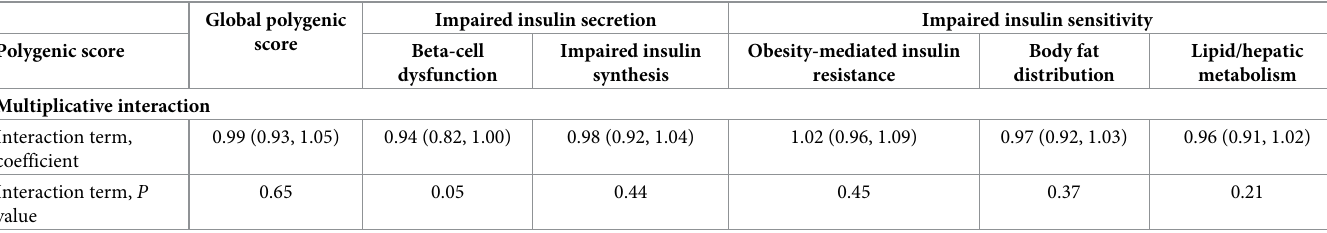
Table 3. Multiplicative interactions between diet quality and genetic risk on the risk of type 2 diabetes.